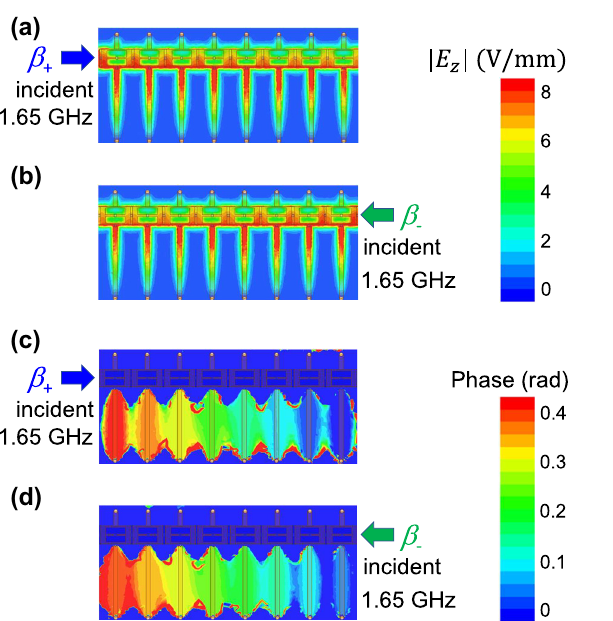
Figure 8: Magnitude and phase distribution of the electric field component E z observed on a plane a half the substrate thickness above the ground plane at 2.47 GHz. (a), (b) Magnitude. (c), (d) Phase distribution. (a), (c) Signal incidence from left port 1 and (b), (d) from right port